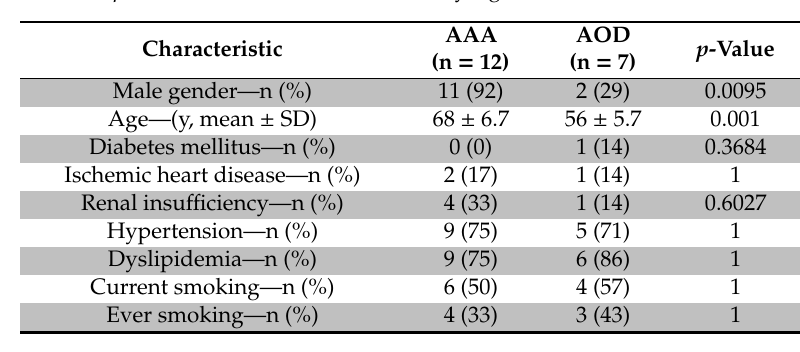
Table 2. Characteristics of the cohort used for tissue collection. A t -test (continuous data) or Fisher’s exact test (categorical data) was applied for the analysis between groups. All statistical analyses were performed using Graphpad Software (Graphpad Software Inc., La Jolla, CA, USA). All statistical tests were two-sided and p < 0.05 was considered statistically significant.